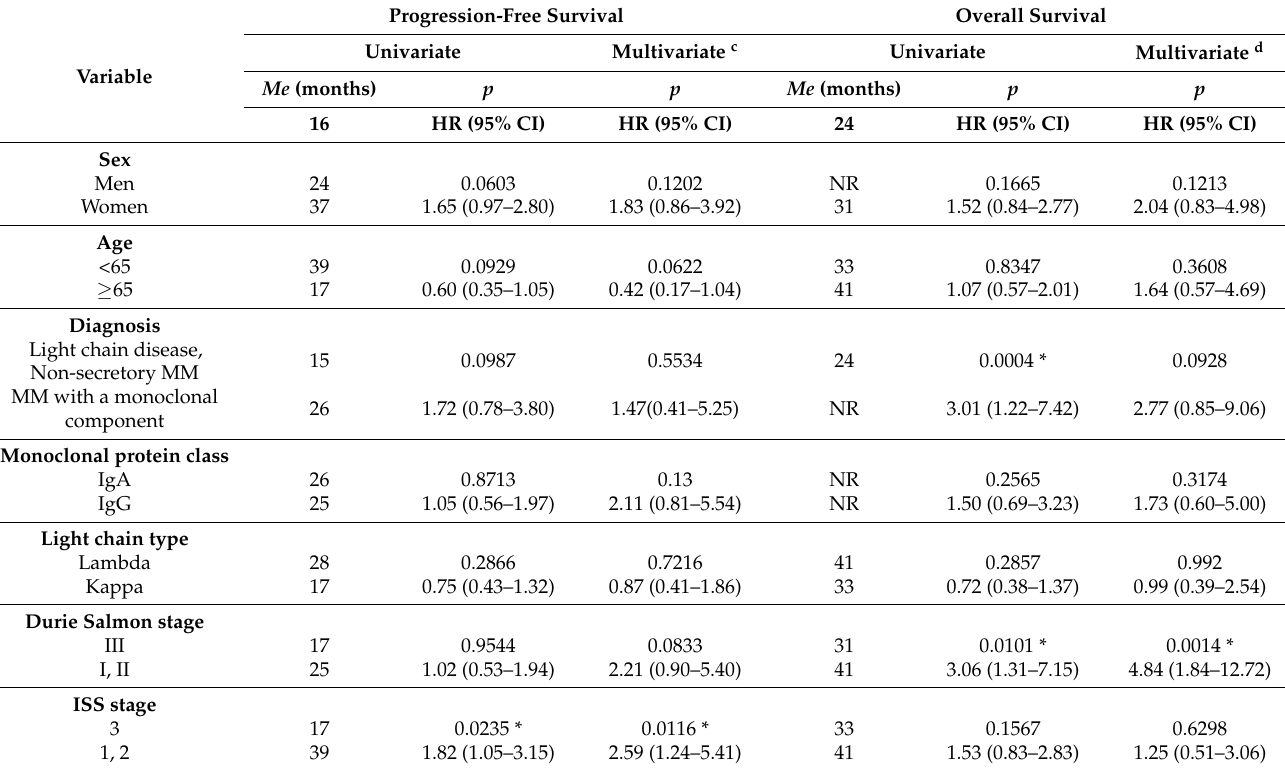
Table 2. Median PFS and OS of MM patients depending on selected factors.